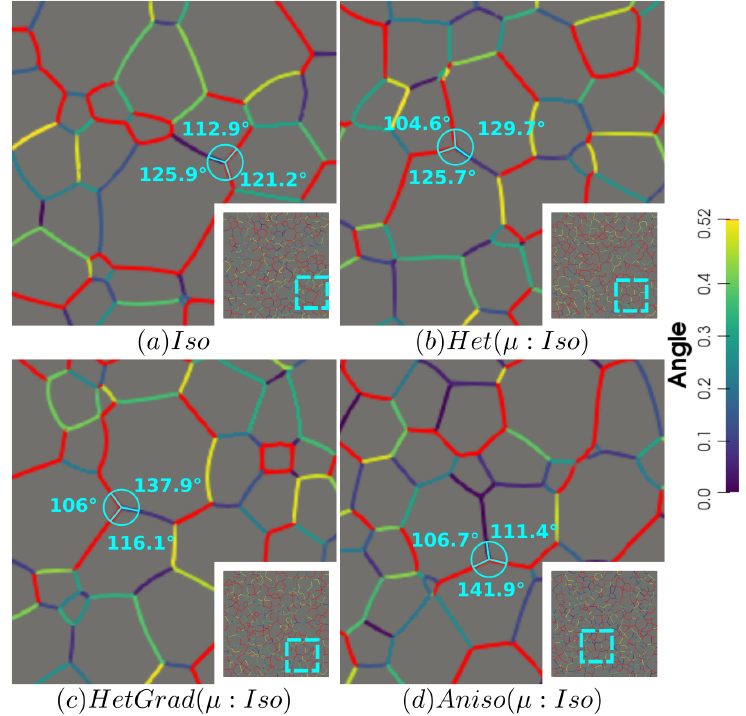
Figure A10. TJ dihedral angles among boundaries with high (red) and low (blue) GB energy. The disorientation of the boundaries is also depicted for the four formulations and homogeneous grain boundary mobility at t = 2 h. Boundaries with a disorientation higher than 30 ◦ are colored in